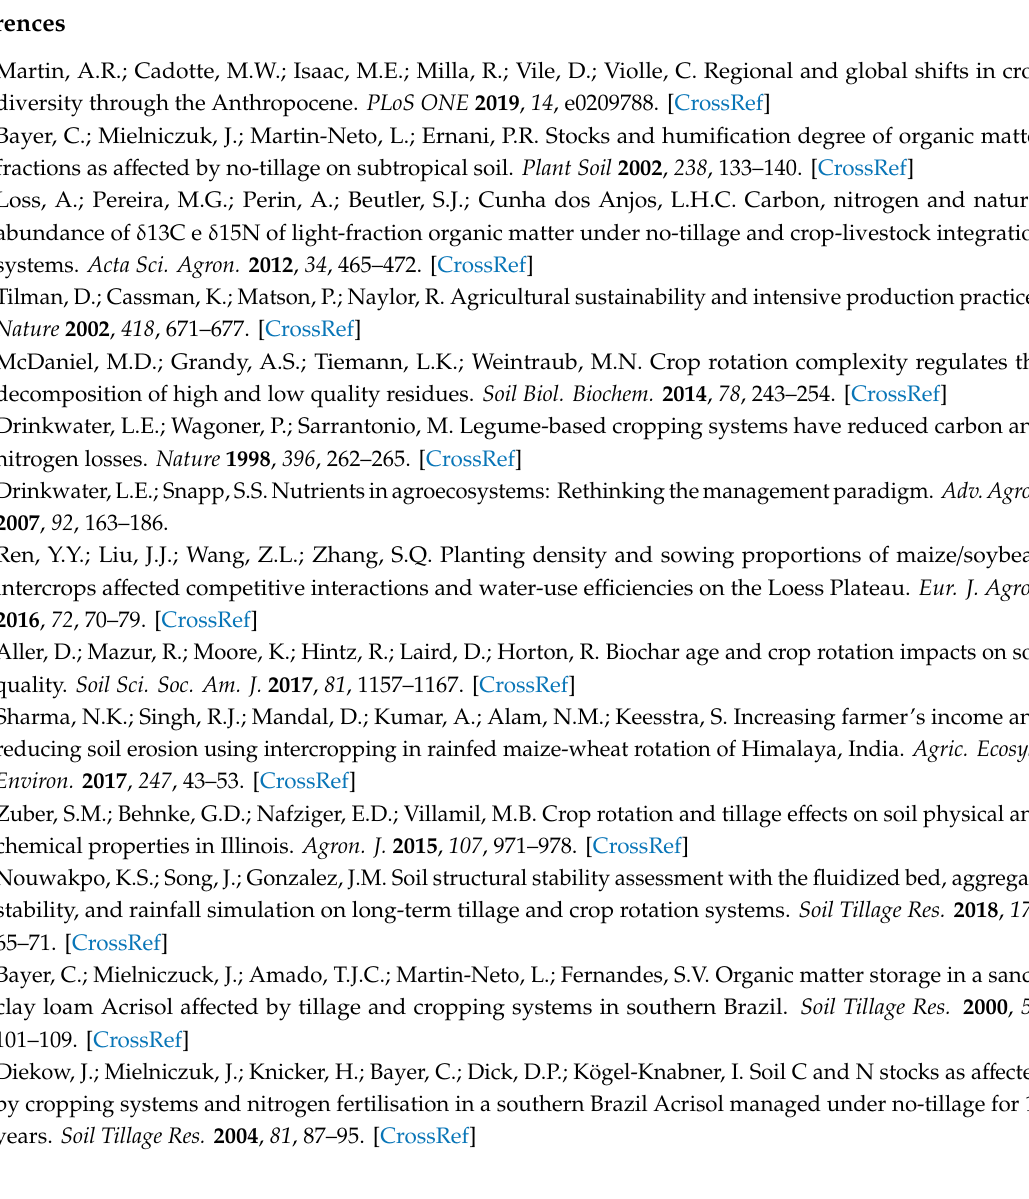
Supplementary Materials: The following are available online at http: // www.mdpi.com / 2571-8789 / 3 / 3 / 50 / s1, Table S1: Abundance matrix (generated from Illumina sequencing data) including the relative abundance, at genus level, for each treatment, in 12 replicates (n = 108). Table S2: Results from a constrained ordination (RDA) evaluating the e ff ects of planting arrangement and nine soil variables on microbial community composition. Statistically significant parameters (where p ≤ 0.05) are highlighted in bold. Table S3: Spearman rank correlation coe ffi cients (Spearman’s ρ ) between the 30 most abundant genera and soil features. Red cells correspond to correlations where Spearman’s ρ is statistically significantly negative (where p ≤ 0.01), while blue cells correspond to correlations where Spearman’s ρ is statistically significantly